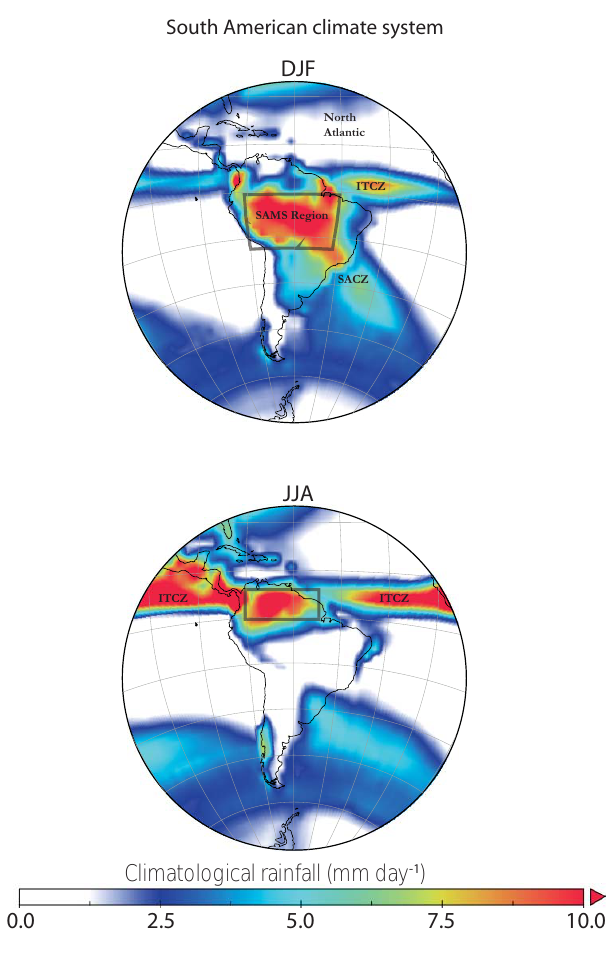
Figure 2. Top: observed Climatological Precipitation for DJF (shading, in mmday − 1 ). SAMS box is drawn over the domain from 20 to 0 ◦ , 77.5 to 45 ◦ W and used for Figs. 9 and 12. Data from the GPCP product, long-term climatological rainfall derived from years 1981–2010. Bottom: as above, except for JJA. Box from 0 to 10 ◦ N, 77.5 to 52.5 ◦ W used in averaging for Figs. 9 and